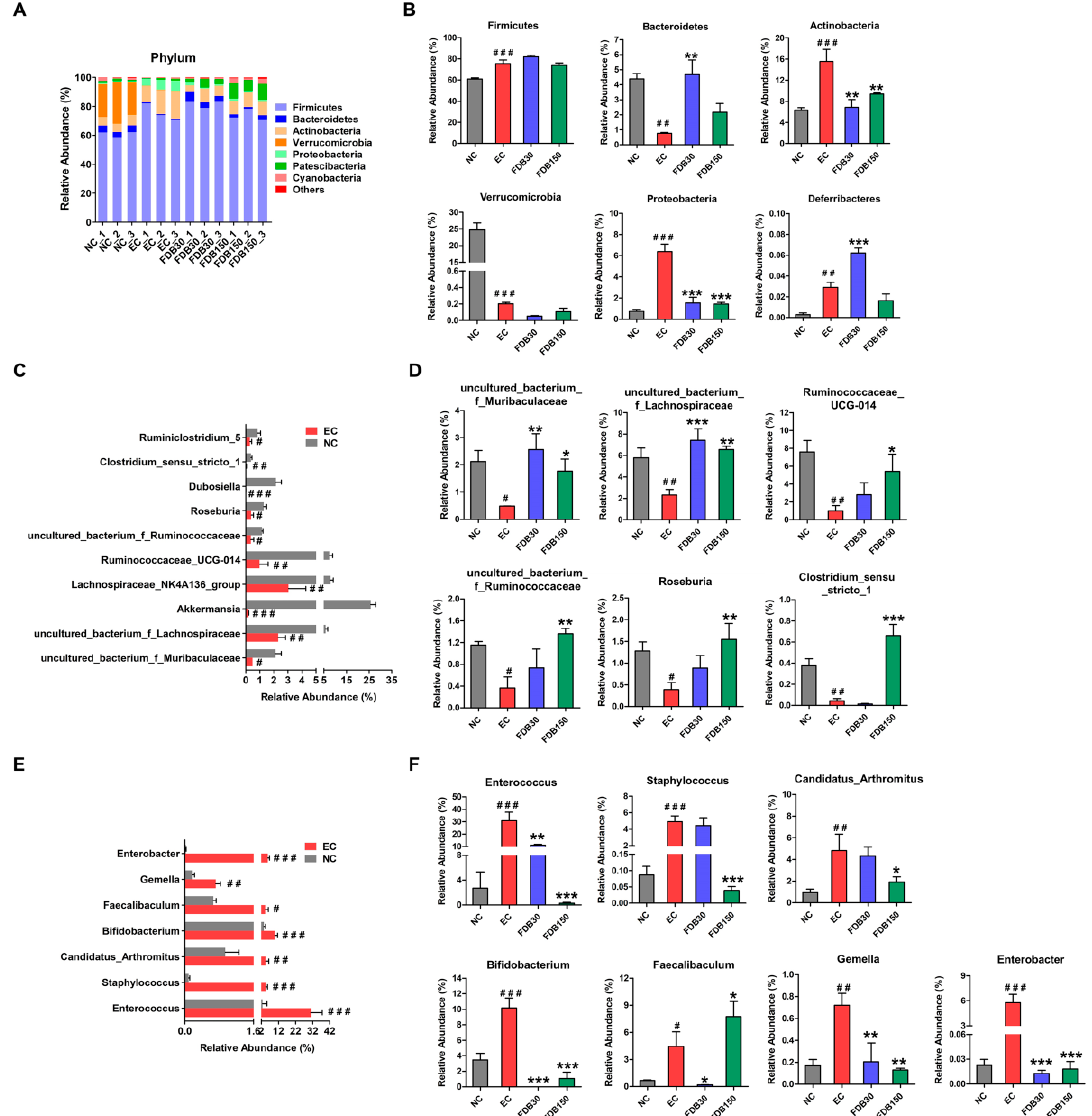
Figure 3. FDB supplementation altered the composition of small intestinal microbiota in fatigued mice. ( A ) Taxonomic distributions of bacteria from small intestine content 16S rDNA sequencing data at the phylum level. Relative abundance of significantly altered bacterial taxa at ( B ) phylum and ( C , E ) genus levels between NC and EC mice. ( D , F ) Relative abundance of significantly altered bacterial taxa at genus level between EC and FDB mice. # p < 0.05, # # p < 0.01, and # # # p < 0.001 vs. normal control (NC) group; * p < 0.05, ** p < 0.01, and *** p < 0.001 vs. exercise control (EC) group. FDB30: 30 mg/kg FDB group; FDB150: 150 mg/kg FDB group.